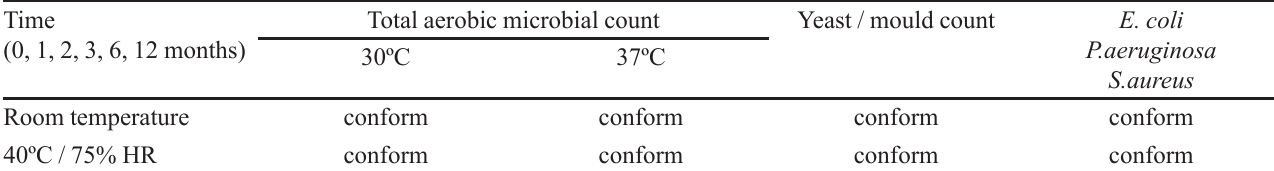
TABLE III - Microbiological results of the lots stored at room temperature and for the lots stored in the oven. Time (0, 1, 2, 3, 6, 12 months)